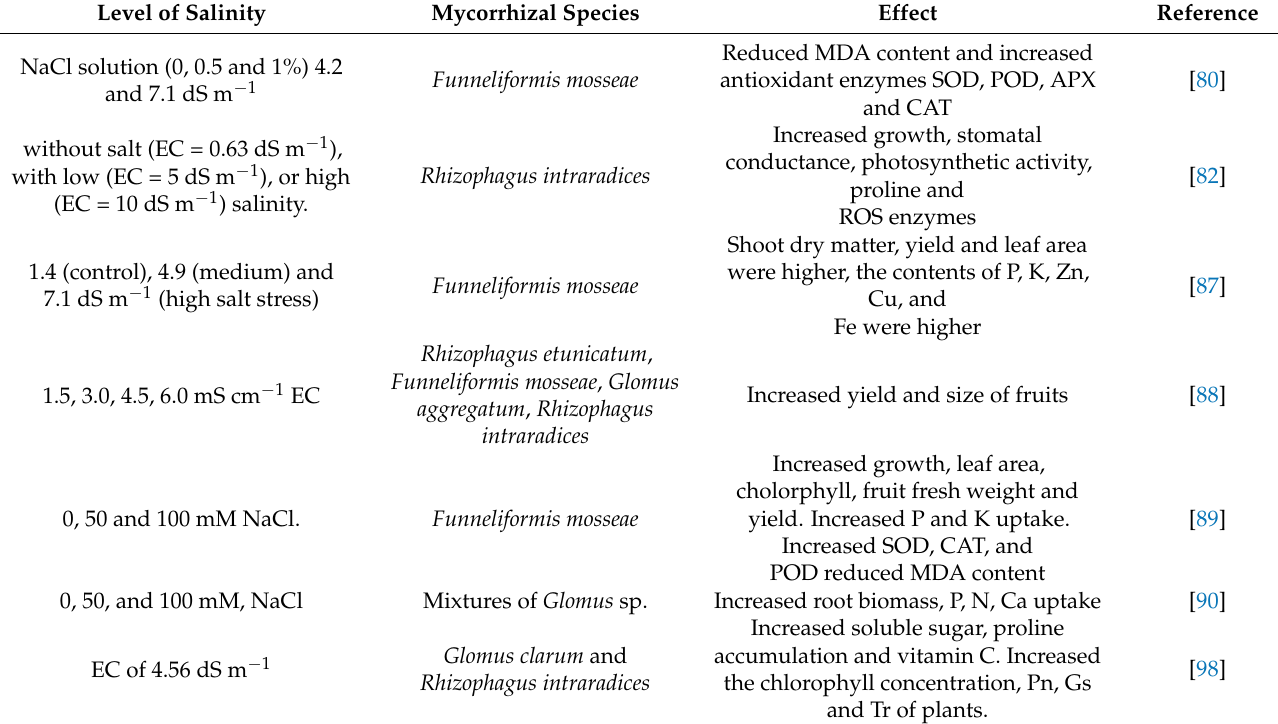
Table 2. Application of arbuscular mycorrhizal fungi on salt stress